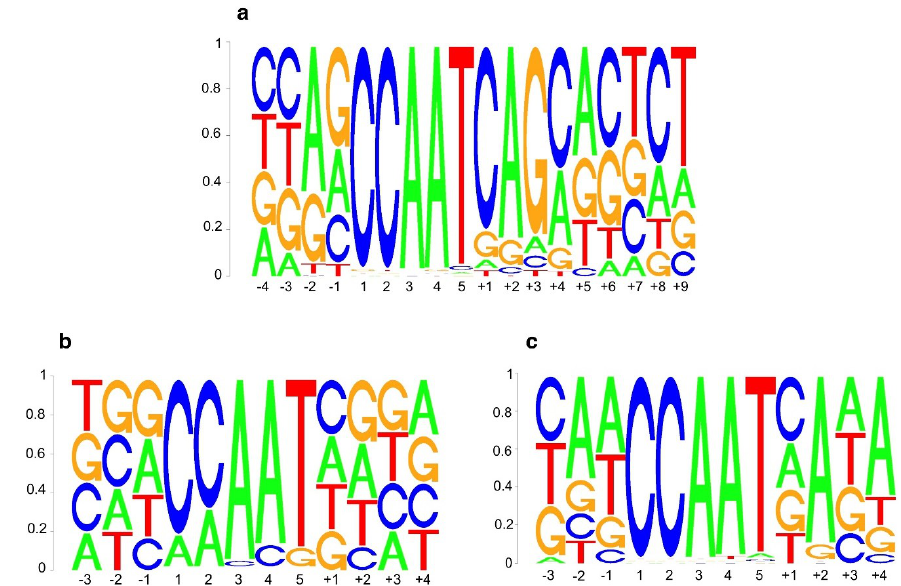
Figure 5. Comparison of sequence-specificity of CCAAT box elements in human and Arabidopsis NF-Y. ( a ) Human sequence logo of the CCAAT box element as derived from de novo motif discovery analysis of 12,655 NF-YB ChIP-Seq peaks from the human K562 cell line [3]. ( b ) A. thaliana sequence logo of the